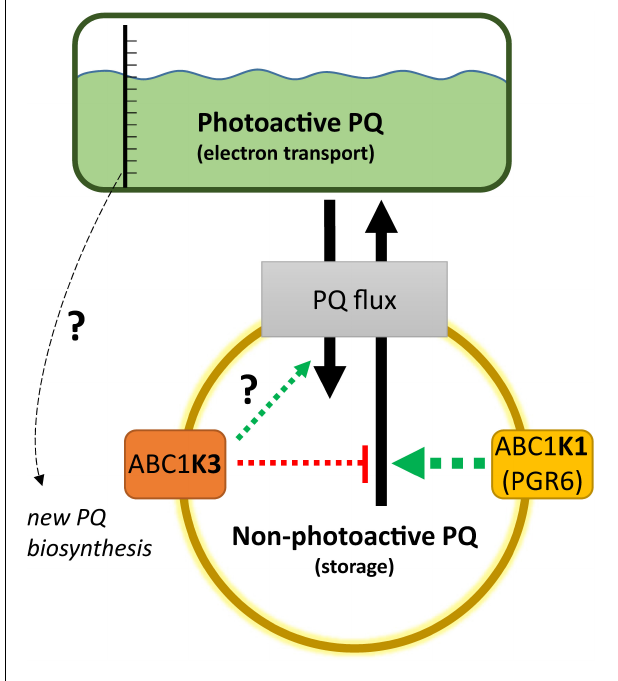
FIGURE 8 | Working model on the activity of ABC1K1 and ABC1K3 on the plastoquinone (PQ) redistribution. The two atypical kinases are enriched in the plastoglobule proteome, therefore presumably in the proximity of the non-photoactive PQ pool. The activity of the ABC1K1 promotes the mobilization of PQ toward the photoactive pool, while ABC1K3 counteracts this mobilization thus favoring the accumulation of PQ in the non-photoactive pool. In the absence of both kinases the PQ tends to accumulate in the non-photoactive pool, therefore a positive regulation of ABC1K3 on the flux from the photoactive to the non-photoactive pool is not essential, as highlighted by the question mark, but cannot be excluded in this model. The observation that in absence of both kinases PQ tends to accumulate in the non-photoactive pool suggests a prominent role of ABC1K1 in the PQ flux regulation (larger arrow). A not yet identified sensor of the size and/or the redox state of the photoactive PQ pool may serve to regulate the level of PQ biosynthesis. When the relative size of the photoactive pool is larger, and the electron transport more efficient as in the abc1k3 mutant, the signal promoting PQ biosynthesis may be dimmed resulting in a lower amount of total PQ. The dashed arrows represent that the regulation of the PQ fluxes, mediated by the two atypical kinases, is likely to be indirect. Although the effect on PQ flux is opposite, the presented working model cannot exclude that the two atypical kinases act via separate mechanisms and that the impact observed on PQ mobility is a consequence of the alteration of their primary